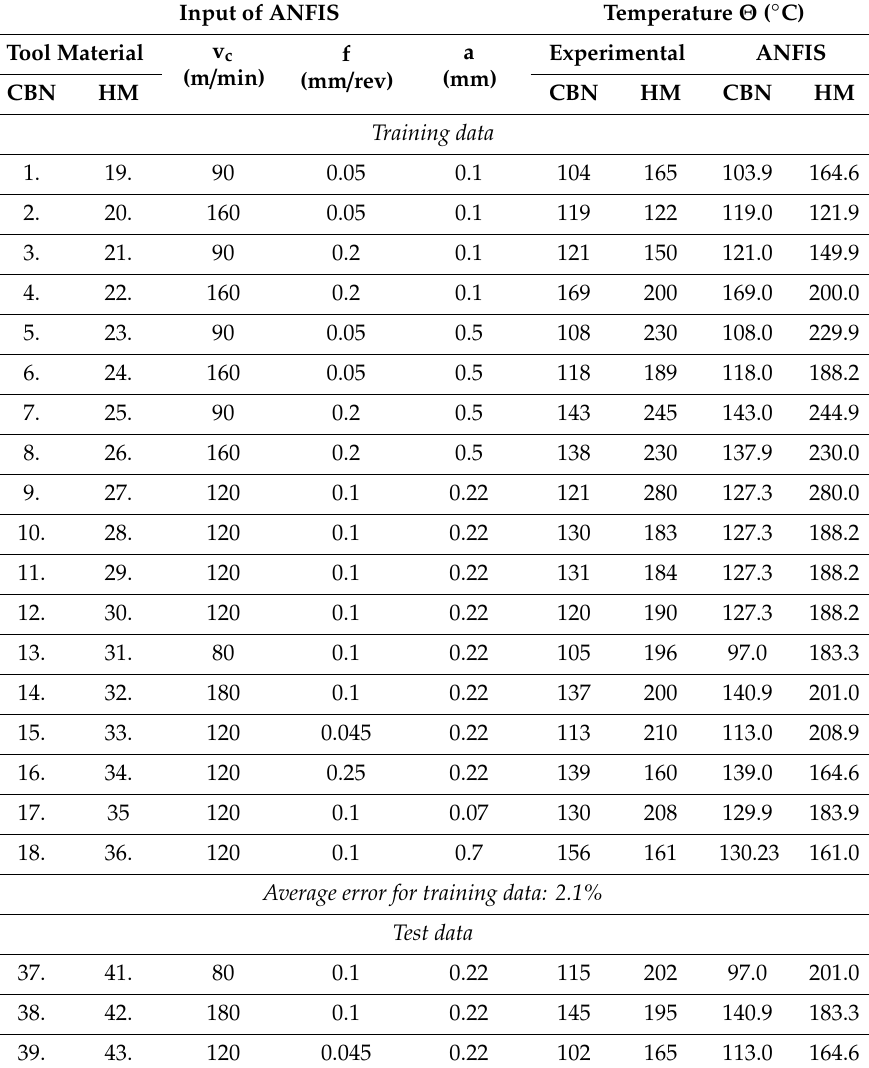
Table 6. Experimental plan and